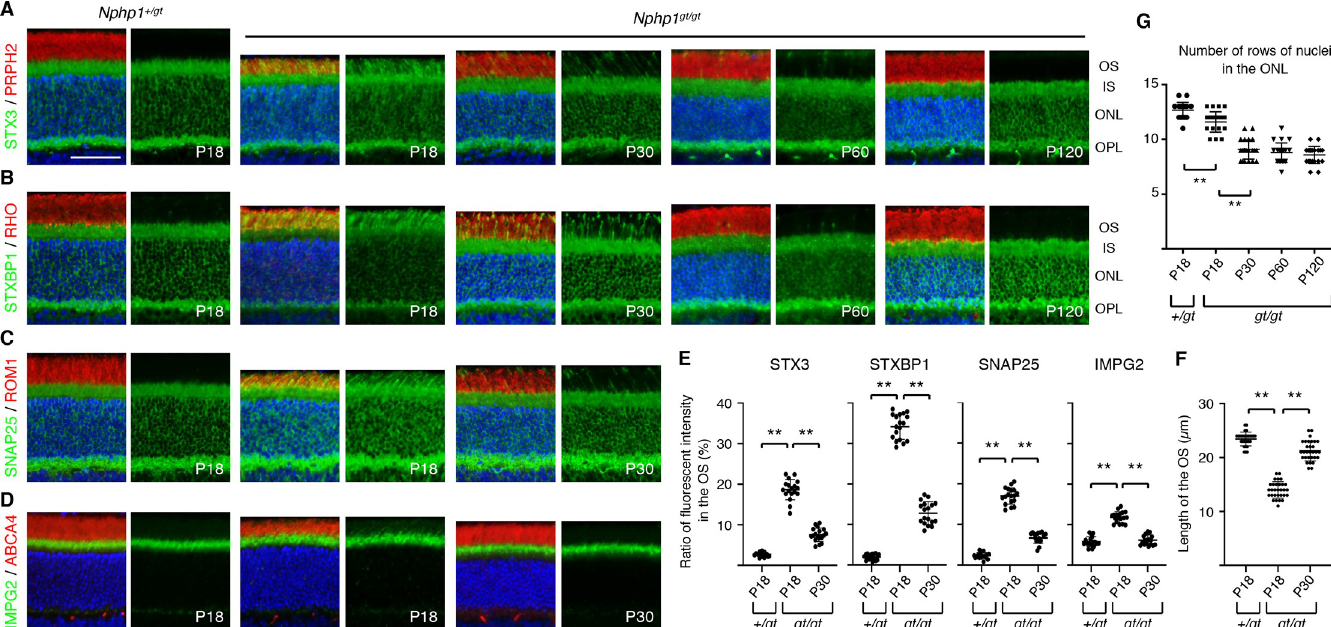
Fig 1. Protein confinement defects and photoreceptor cell loss in Nphp1 gt/gt mice. (A-D) Transient mislocalization of STX3 (A), STXBP1 (B), SNAP25 (C), and IMPG2 (D) in Nphp1 gt/gt retinas. Retinal sections from Nphp1 +/gt and Nphp1 gt/gt mice were stained with STX3, STXBP1, SNAP25, and IMPG2 antibodies (green). PRPH2, RHO, ROM1, and ABCA4 (red) were labeled as a marker of the OS. Merged images are shown on the left. DAPI (blue) was used to counterstain the nuclei. Scale bar denotes 50 μ m. IS: inner segment, ONL: outer nuclear layer, OPL: outer plexiform layer. OS: outer segment. (E) Quantification of IS membrane protein mislocalization to the OS. Depicted are the ratios of integrated fluorescence intensities in the OS relative to the photoreceptor cell layer. Means ± standard deviations (SD; error bars) are marked by horizontal lines (n = 3 mice; 2 sections/mouse and 3 areas/section). (F) Transient shortening of the OS in Nphp1 gt/gt retinas. The length of the OS was measured in Nphp1 +/gt and Nphp1 gt/gt mice at the central retina, and mean ± SD is depicted (n = 4 mice; 3 sections/mouse; 2–3 locations/section). (G) Photoreceptor cell loss in Nphp1 gt/gt retinas. The number of rows of photoreceptor cell nuclei was counted in Nphp1 +/gt and Nphp1 gt/gt mice at the central retina (n = 4 mice; 3 sections/mouse; 2 locations/section). Asterisks indicate statistical significance (one-way ANOVA followed by Tukey’s multiple comparison test; p < 0.01).